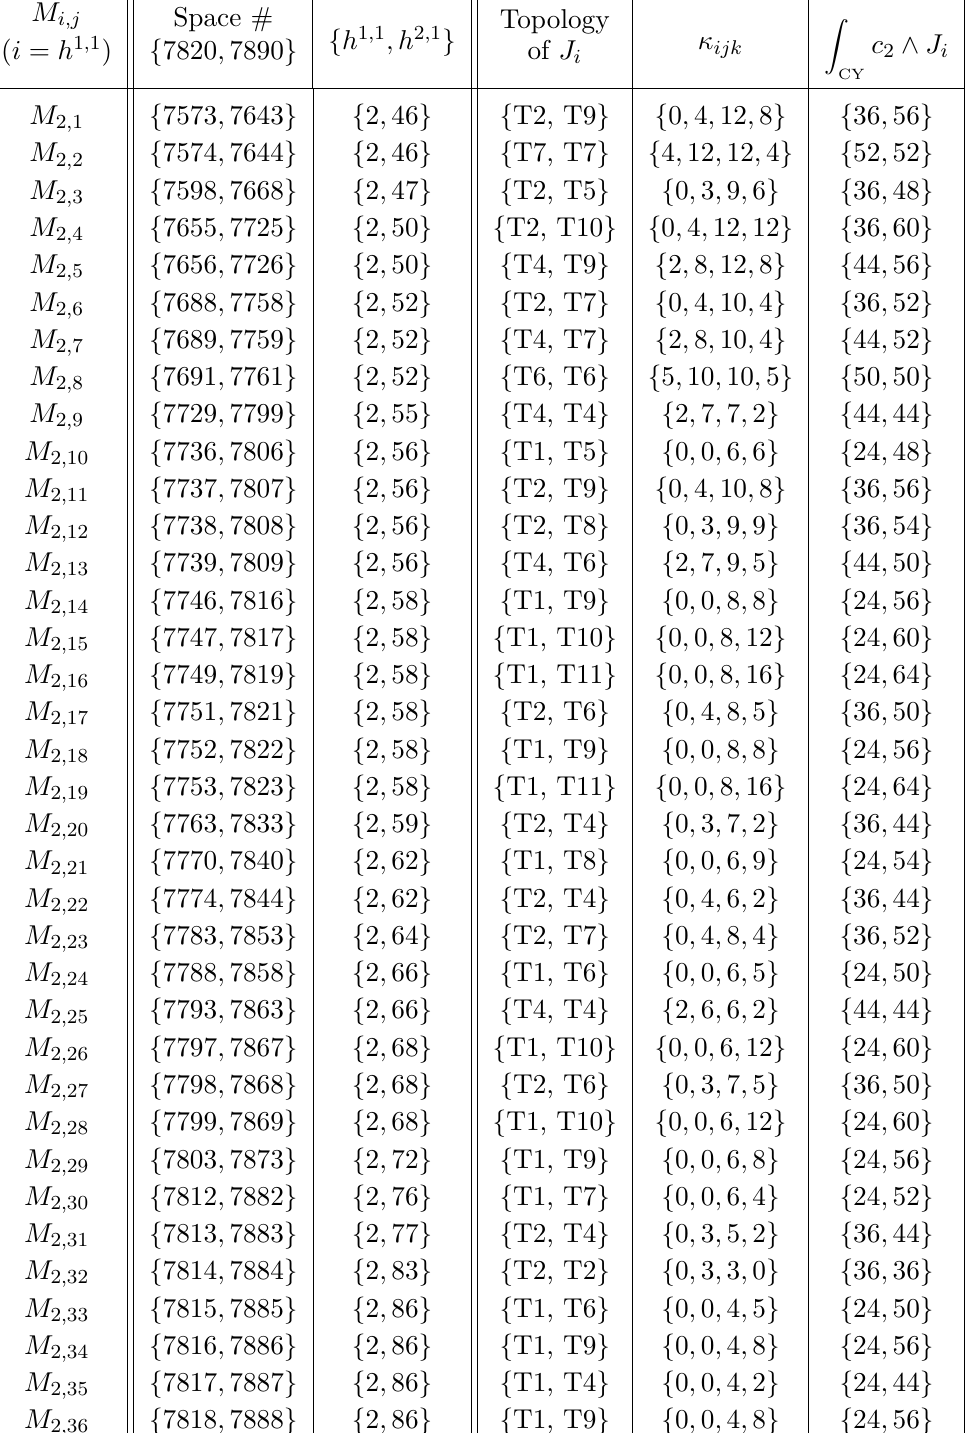
Table 15 . Topological data for favorable pCICYs with h 1 , 1 = 2 . The intersection numbers κ ijk are collected as { κ , while other details for topologies Ti’s are given in table 111 , κ 112 , κ 122 , κ 222 }